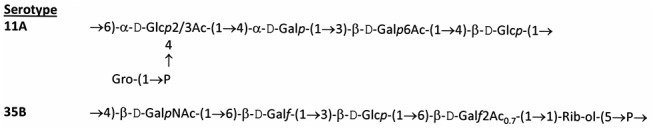
Primary structures of the capsular polysaccharides of S. pneumoniae serotypes 11A and 35B.Data were taken from previous studies [13,27].